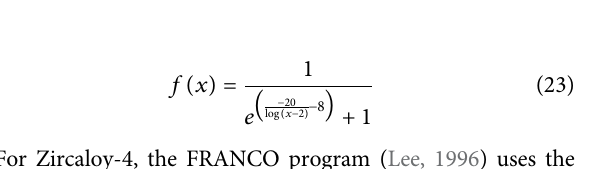
FIGURE 6 | Experimental measured and predicted centerline temperature for